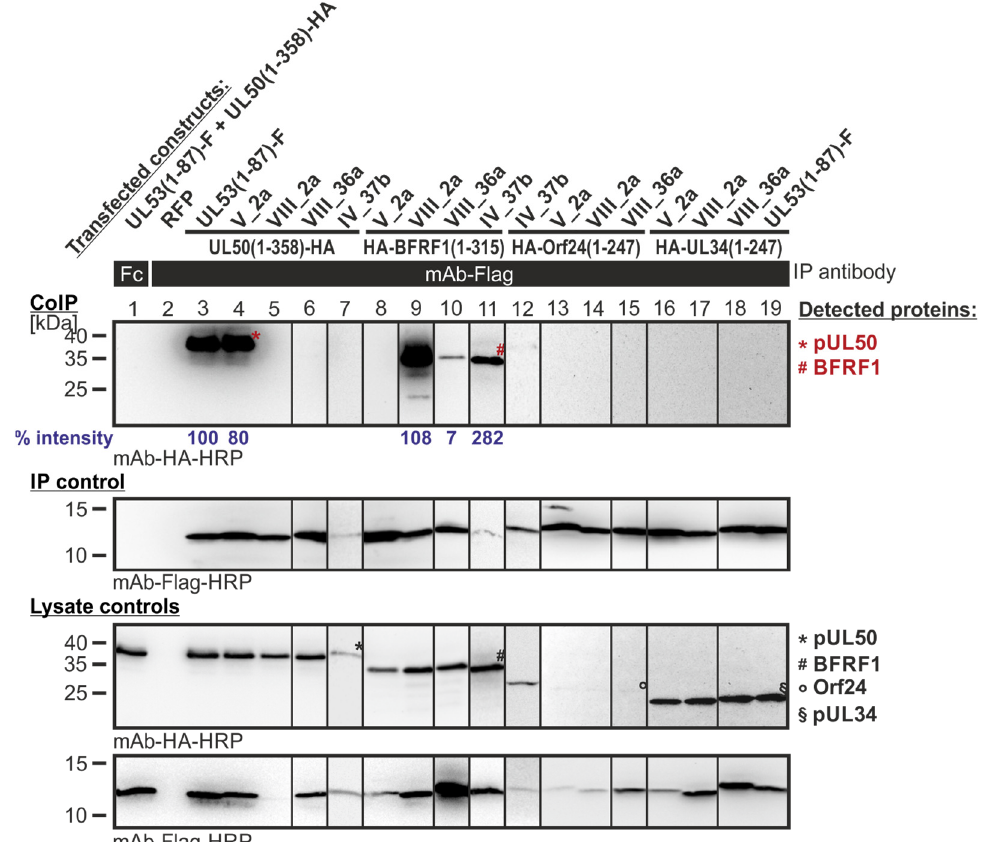
Figure 8. CoIP ‐ based interaction analysis of HCMV pUL50, EBV BFRF1, VZV Orf24 and HSV ‐ 1 pUL34 with the library clones that exerted shared ‐ hook binding activity in the primary screening of Lib1 with BFRF1. 293T cells were transiently transfected with plasmids coding for the HA ‐ tagged groove proteins, pUL50, BFRF1, Orf24, or pUL34, lacking their TMD, in combination with the Flag ‐ tagged library constructs. The wild ‐ type interaction of truncated pUL53 with pUL50 served as a positive and RFP as a negative control. At three d p.t., cells were lysed and Flag ‐ tagged proteins were immunoprecipitated using mAb ‐ Flag; a chicken Fc fragment served as a specificity control. Lysate controls taken prior to the IP and CoIP samples were subjected to standard Wb analysis using tag ‐ specific antibodies as indicated. Blue numbers: each individual CoIP band was first normalized to the corresponding IP signal and was then set in relation to the reference WT interaction (% intensity) using Aida Image Analyzer v.4.23 software (mean values of triplicate densitometric determinations are given); CoIP was performed once.